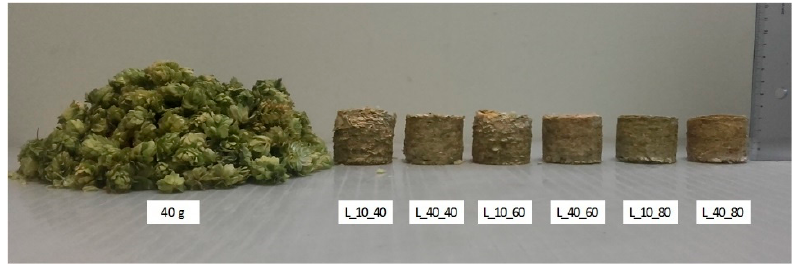
Figure 1. Bulking hop cones and compacts obtained during the experiment.